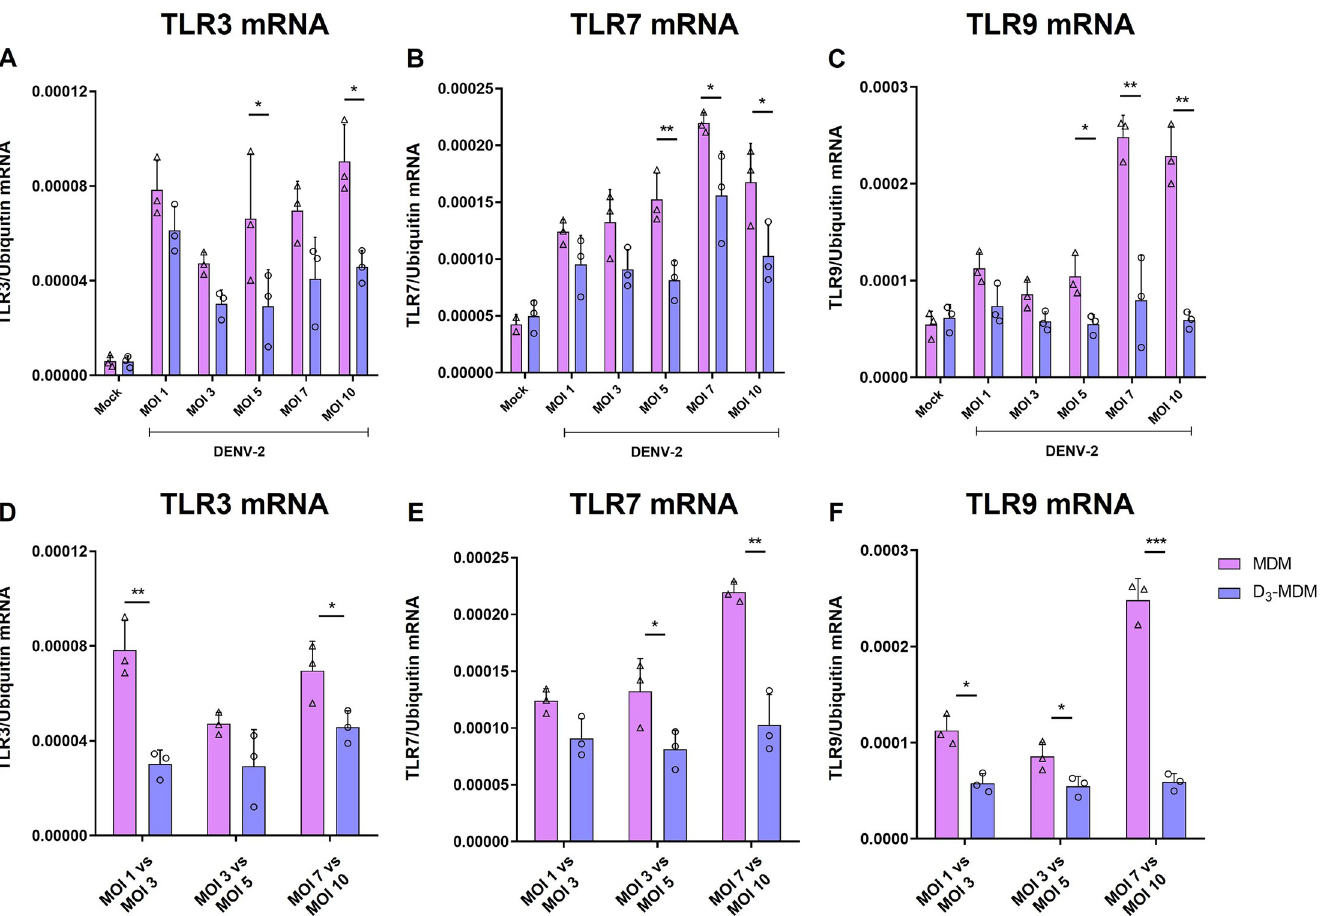
Fig 3. Regulation of TLR expression is independent of the MOI used. The MDMs were differentiated in the presence of VitD3 (0.1 nM) for 6 days (D 3 -MDMs) and then infected with DENV-2 with different MOI for 24 h. Expression of TLR3 (A and D), TLR7 (B and E), and TLR9 (C and F) were measured by qPCR in MDMs and D 3 -MDMs using ubiquitin as housekeeping. Data are expressed as fold change relative to mock-treated MDMs and D 3 -MDMs. Three different donors were analyzed. Differences were obtained with a two-way ANOVA with a Bonferroni posthoc test and a 95% confidence interval ( ��� p < 0.001, �� p < 0.01, � p <